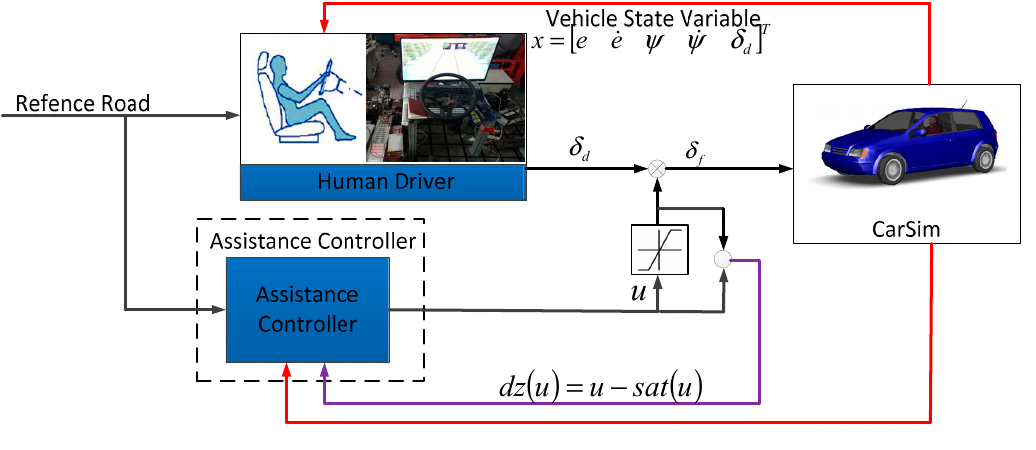
Figure 2. Structure of the proposed method.